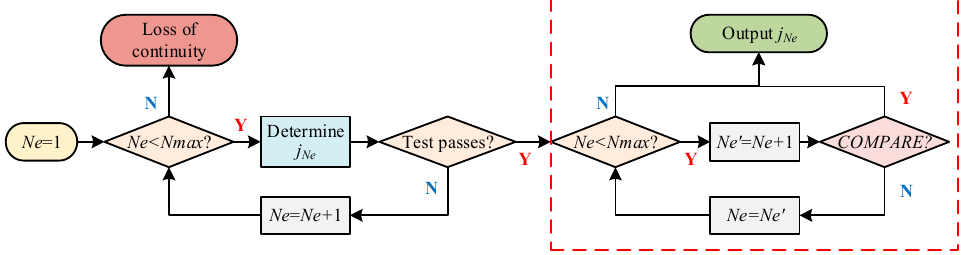
Figure 5. Flowchart of the determination of best candidate for GNSS fault exclusion.